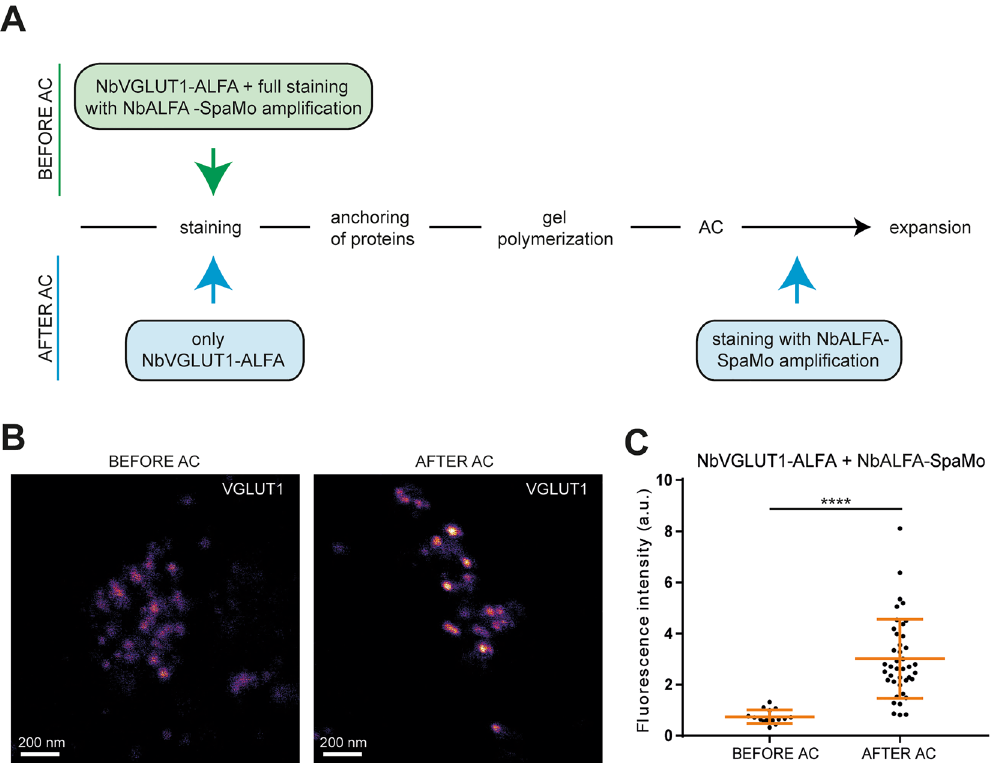
Figure 5. Application of the NbALFA-SpaMo system before and after sample denaturation via autoclave (AC). ( A ) Scheme of two possible workflows for the NbALFA-SpaMo application. ( B ) Representative confocal images for both NbALFA-SpaMo applications before or after AC. ( C ) A quantification of the signal intensities in the different protocols. N = 15 images for before AC and 41 images for after AC with several ROI analyzed, obtained from two experiments. Data are presented as individual data points, mean ±